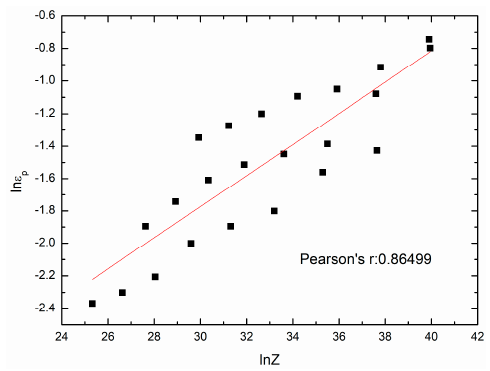
Figure 7. The relationship between ln p ε and ln Z . Materials 2017 , 10 , x FOR PEER REVIEW